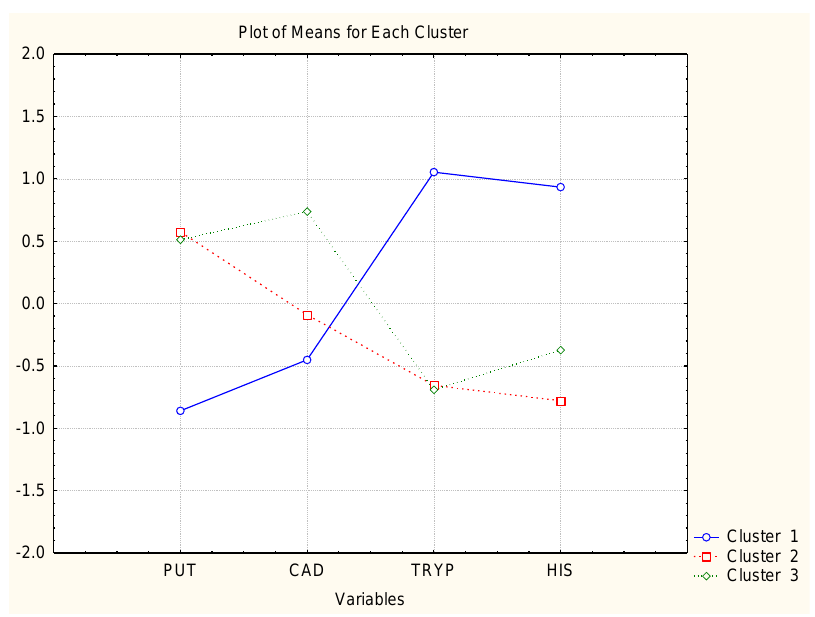
Figure 5. Averages of variables for each cluster (Wine B).